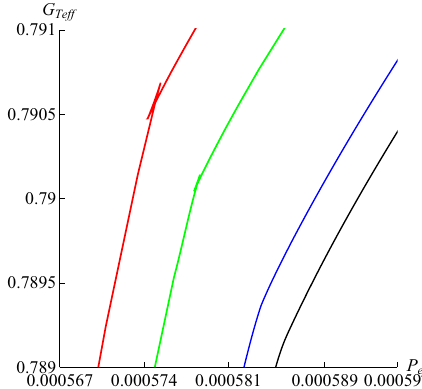
Fig. 2 G Tef f − P ef f with the non-linear correction ¯ φ = 10 − 5 and k = 1 , q = 1. The effective temperature is set to 1 . 001 T c lines), T c (blue lines), 0 . 997 T c ef f respectively